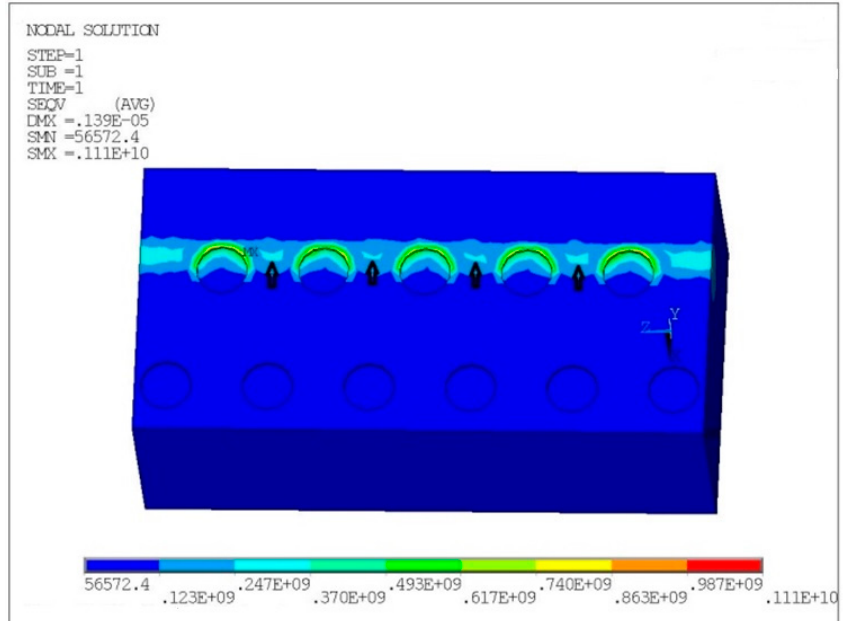
Figure 11. Mises stress distribution on the contact surface of micro-dimpled cylinder liner (space unit: µ m; stress unit: